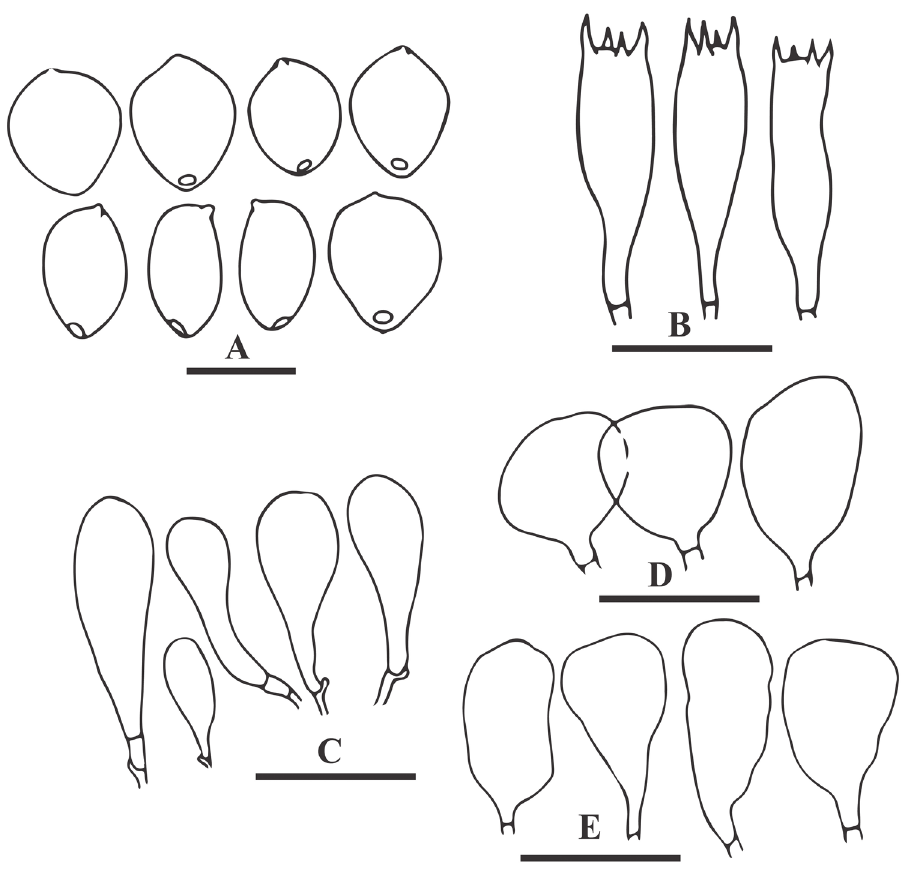
Figure 7. Anatomical features of Parasola pseudolactea sp. nov (HUP-SU-412). A Basidiospores B Basidia C Pileipellis D Pleurocystidia E Cheilocystidia. Scale bars: 12 µm ( A ), 20 µm ( B–E ).